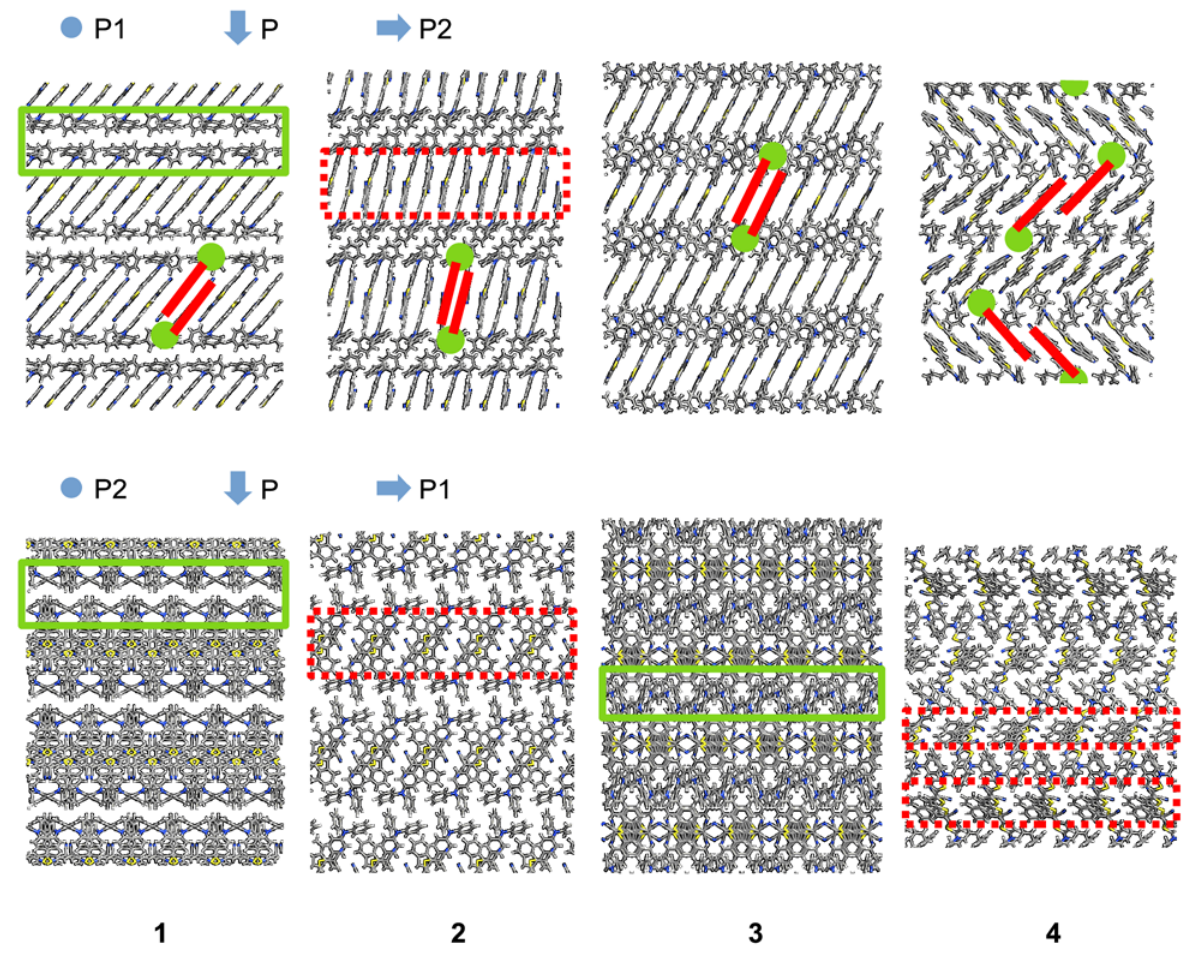
Figure 4. Views of the supercells of compounds 1 through 4 along the directions P1 ( top ) and P2 ( bottom ). The molecules are shown using cylinders to represent bonds. Regions of the cylinders are differently colored to represent carbon, hydrogen, sulfur, and nitrogen using gray, white, yellow, and blue, respectively. The solid (green) and dashed (red) rectangles highlight the phase of the triphenylamine and dicyanovinyl moieties, respectively. Two adjacent molecules are simplified using a line (red) representing the dicyanovinyl and a circle (green) representing the triphenylamine. The crystal of compound 4 is composed of molecules in two different conformations. The transport directions P, P1, and P2 are indicated by arrows, and the circle indicates a direction perpendicular to the